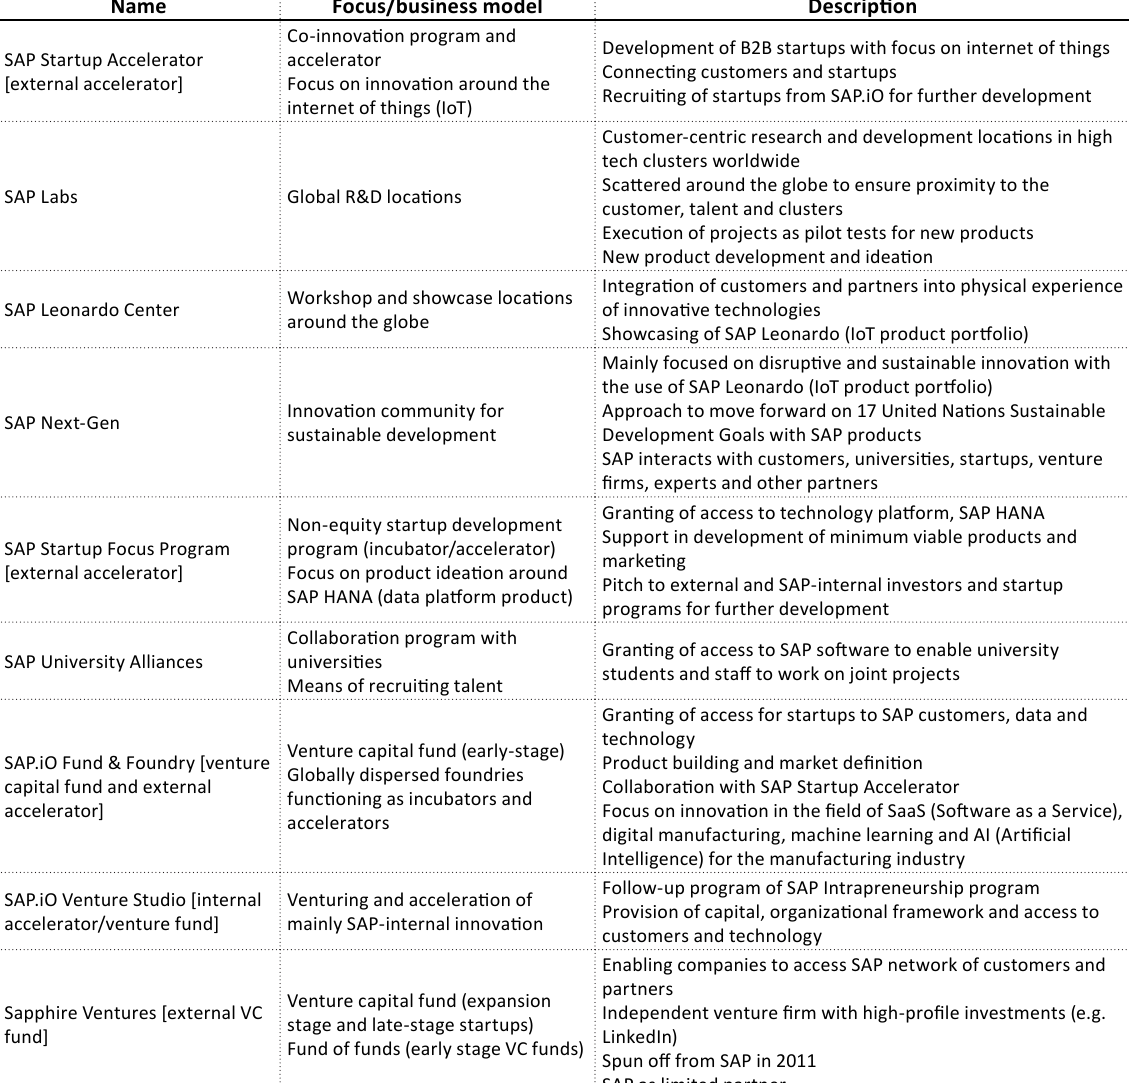
Table A1 (cont.). Overview of innovation, incubation and venturing activities at